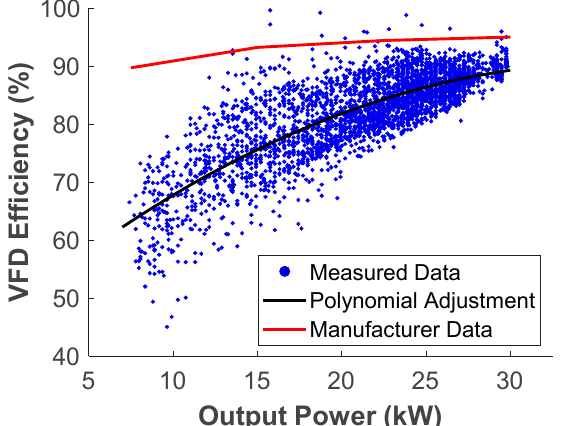
Figure 3. Comparison between the VFD efficiency supplied by the manufacturer and the output power measured.